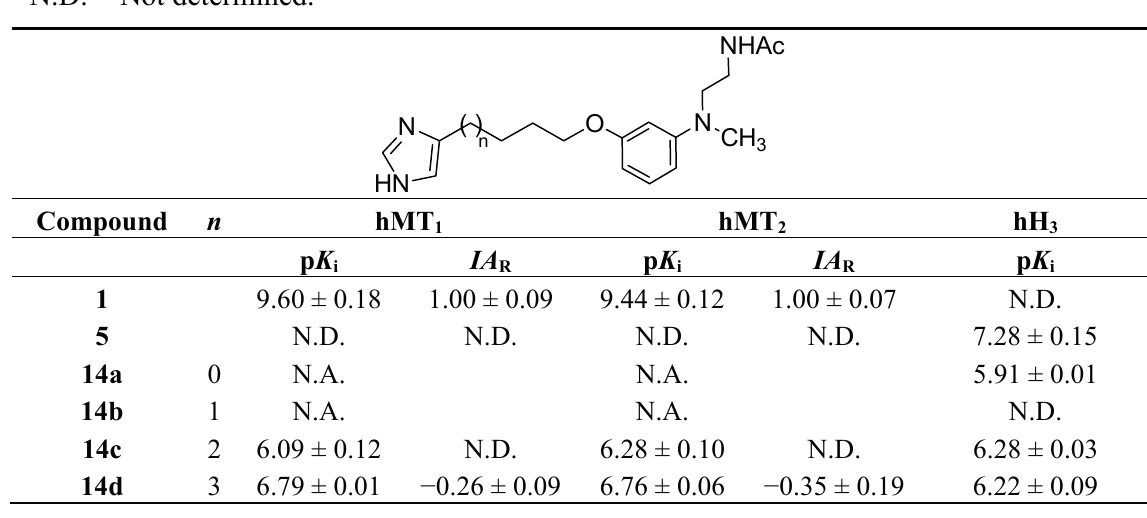
Table 1. Binding affinities (p K i ) and intrinsic activities ( IA R ) measured for compounds 14a – d at the human MT 1 , MT 2 and H 3 receptors. N.A. = Not active up to 100 μ M. N.D. = Not